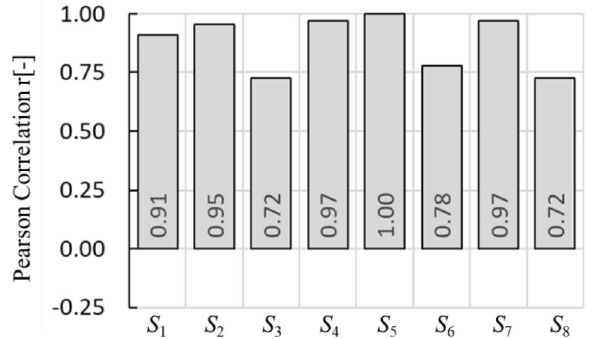
Figure 11. Comparison of Pearson correlation r.